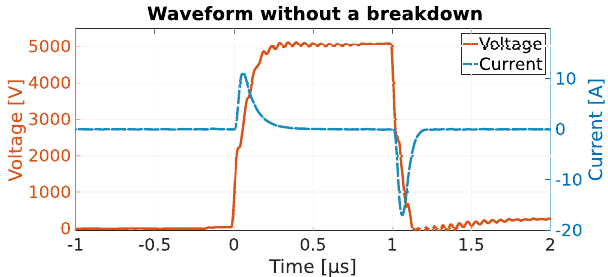
FIG. 2. A typical waveform of a 1 μ s pulse generated by Marx generator without a breakdown. The figure shows the charging and discharging current peaks at the start and at the end the pulse, with the voltage staying constant in between.